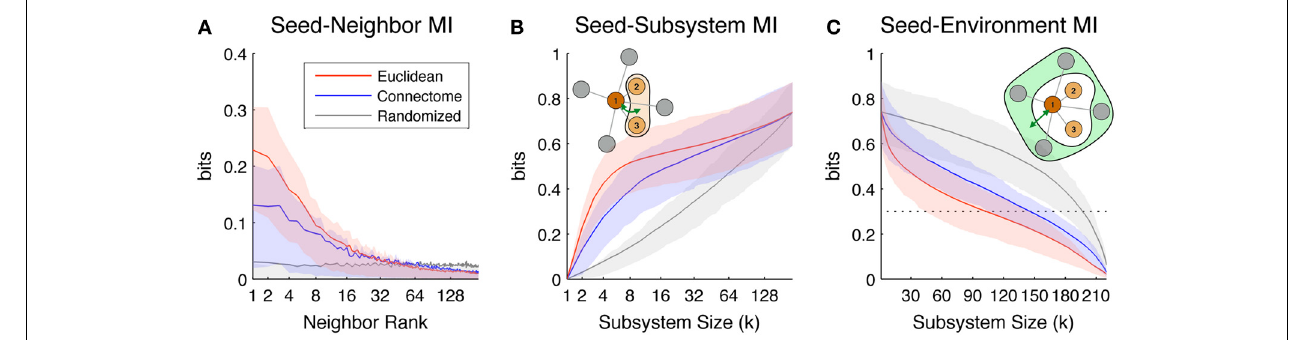
FIGURE 3 | Scaling of the information-theoretic measures of seed predictability. Colored lines indicate mean values across all seed ROIs in both hemispheres, while shaded areas indicate values within 1st and 3rd quartile. Colors indicate values for neighbors/subsystems/environments chosen according to Euclidean (red), Connectome (blue), and Randomized (gray) distance metrics. (A) Average Seed-Neighbor MI between seeds and their corresponding k th rank neighbors chosen according to the three distance metrics. (B) Seed-Subsystem MI between seeds and subsystems